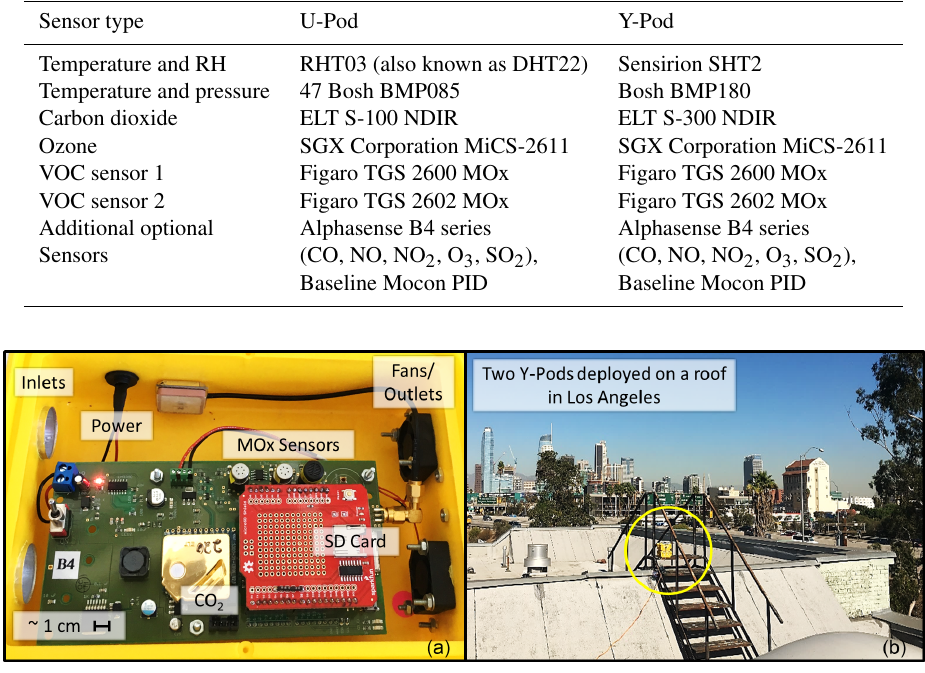
Figure 1. A labeled photo of a Y-Pod interior (a) and a photo of two Y-Pods deployed at a field site (b) .